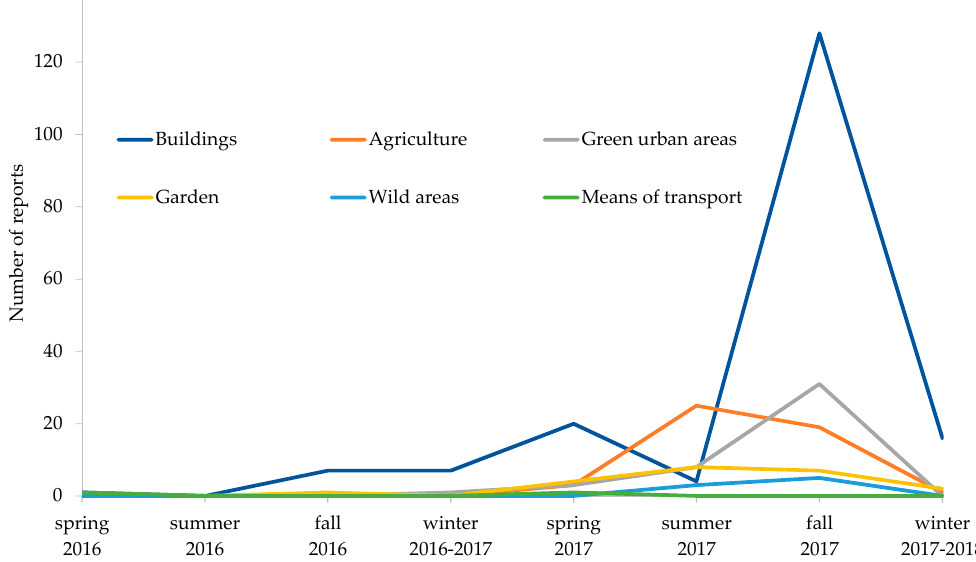
Figure 4. A representation of the varying number of valid BMSB reports in different localities since the initiation of BugMap in spring 2016 up until February 2018.